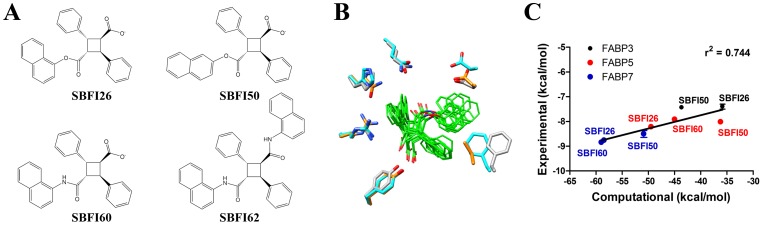
Structures and binding affinities of FABP inhibitors.(A) Chemical structures of FABP inhibitors. (B) Superimposed models of SBFI26, SBFI50, and SBFI60 in the binding pockets of FABP3, FABP5, and FABP7 reveal similar binding geometries. Amino acids lining the binding pockets are shown with teal, gold, and grey representing FABP3, FABP5, and FABP7, respectively. (C) Correlation between binding affinities and energy scores of SBFI26, SBFI50, and SBFI60 for FABP3, FABP5, and FABP7. Linear regression revealed an r2 value of 0.744. The binding affinities and energy scores are derived from Table 1 and Table 2.